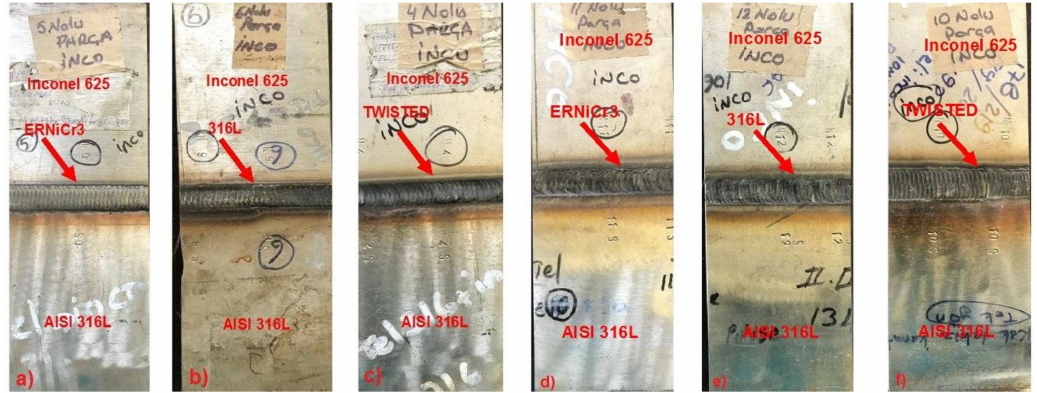
Figure 2. Photographs of the CCGTA ( a – c ) and PCGTA ( d – f ) weldments of Inconel 625 and AISI 316 L.